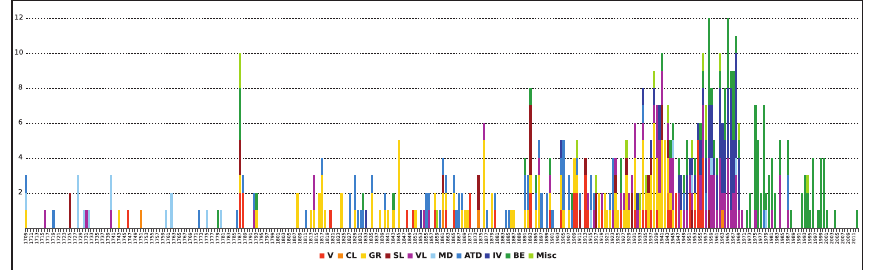
Figure 10: All datable musical references on a timeline (for better legibility, ten ref- erences before 1709 were